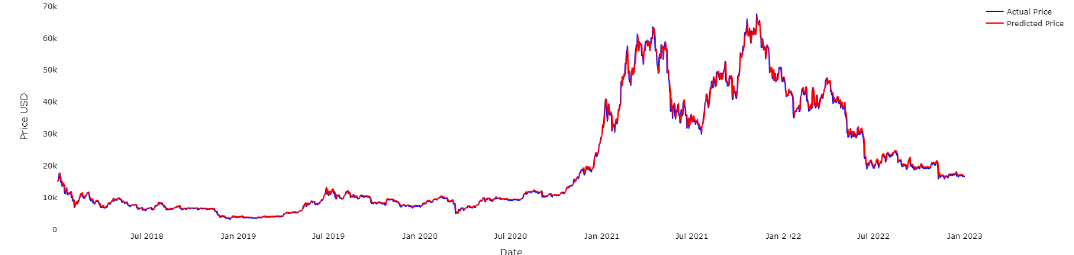
Figure 11. BTC—actual and predicted results using Bi-LSTM model.